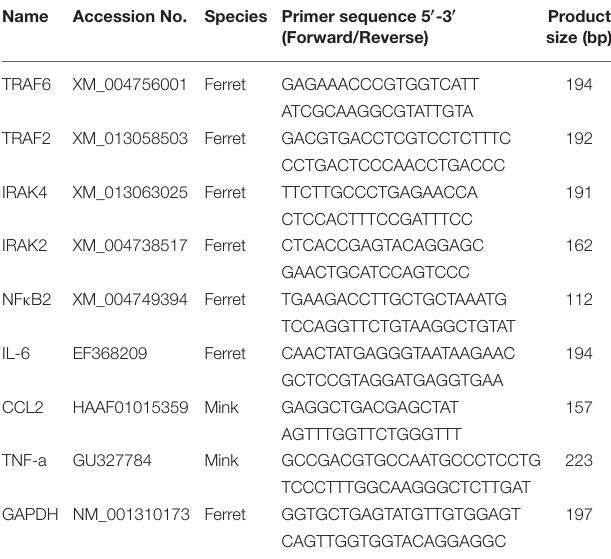
TABLE 1 | Primers used for real-time